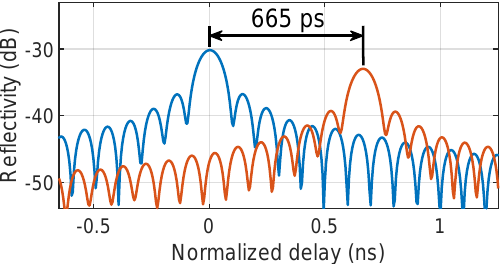
Figure 8. Zoom view of the two rightmost reflective peaks of Figure 7c, corresponding to the FBG at ∼ 1554 nm, with (blue) and without (orange) dispersive element. The window used here is